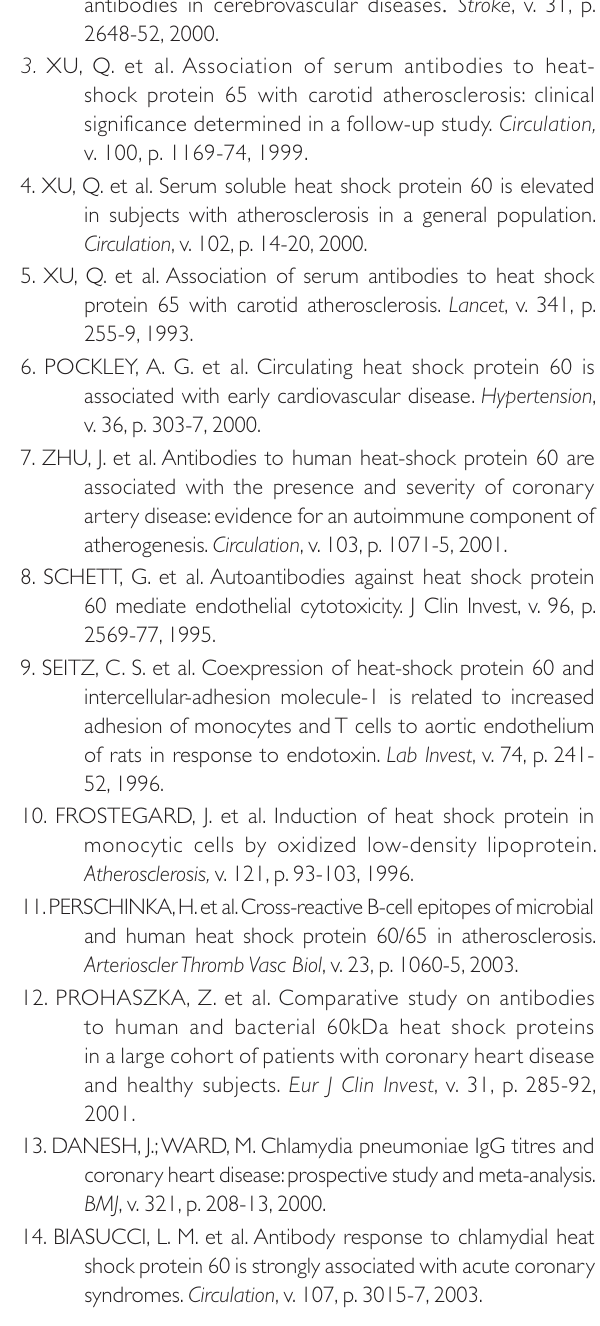
1. STAUB, H. L. et al. Anticorpos contra os componentes da placa aterosclerótica beta 2-glicoproteína I e proteínas de choque térmico como fatores de risco para isquemia cerebral aguda. 2. KRAMER, J. et al. Frequencies of certain complement protein alleles and serum levels of anti-heat shock protein